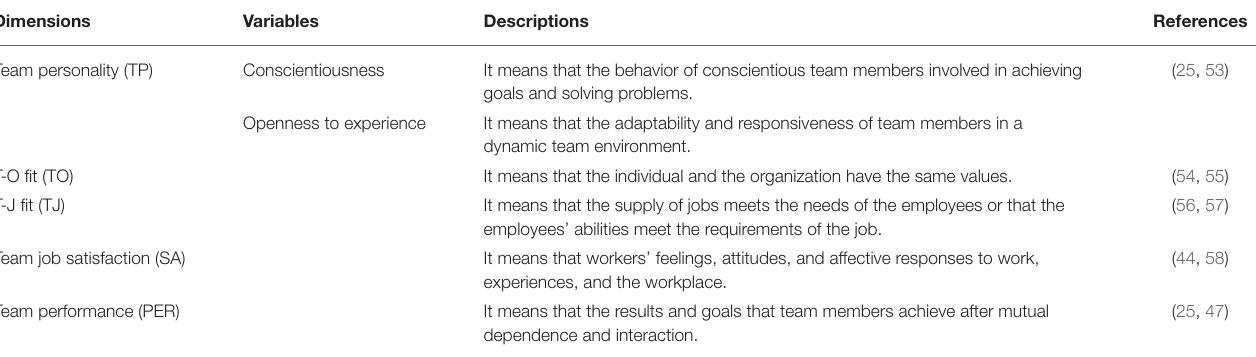
TABLE 1 | Operational